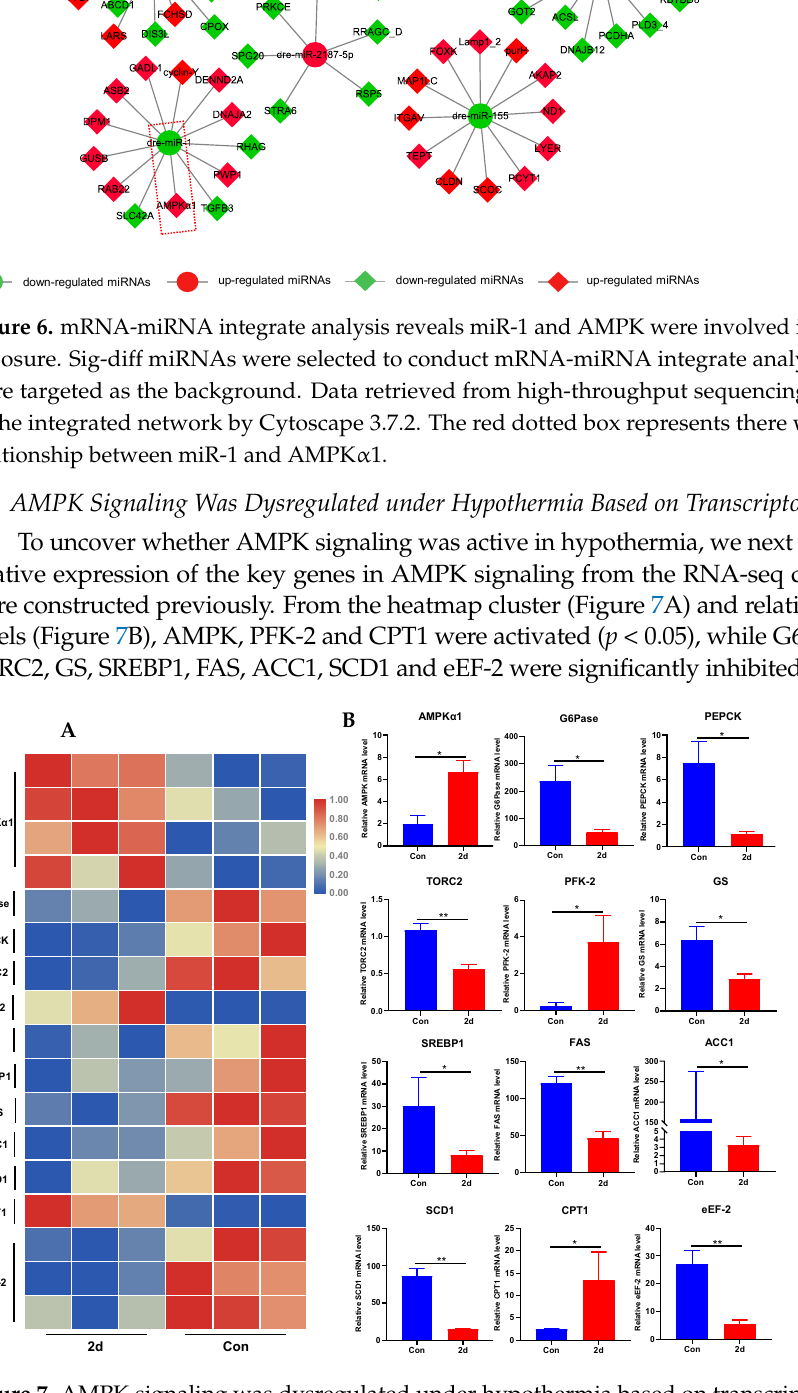
Target predictions indicate that AMPKα1 was the target gene of miR-1 (Figure 8A). To further evaluate whether the AMPK signaling pathway was involved in glucose and lipid metabolism under chronic hypothermia, we investigated the transcriptional expres- sion of key genes. From the results, the regulation between miR-1 and AMPK under chronic hypothermia was confirmed, indicating that the expression of miR-1 was inhib- ited by hypothermia and persisted up to 8 days ( p < 0.05, Figure 8A). Synchronously, the expression of AMPK was also activated at 2 d and 8 d (p < 0.05, Figure 8B). Apart from miR-1 and AMPK, gene expressions of PEPCK, G6Pase, and TORC2 on gluconeogenesis and GS on glycogen synthesis were significantly inhibited at 2 d (Figure 8C–E,G, p < 0.05), while the expression of PFK-2 on glycolysis was activated (Figure 8F, p < 0.05). Importantly, the expression of these genes at 8 d showed no significant changes apart from GS (Figure 8C–G, p > 0.05). Additionally, the mRNA expressions of SREBP1 and ACC1 demonstrated remarkable decreases at 2 d (Figure 8H,K, p < 0.05), while it no- tably increased after hypothermia for 8 days (Figure 8H,K, p < 0.01). Simultaneously, the gene expressions of FAS and SCD1 declined significantly throughout the chronic hypo- thermia (Figure 8I,J, p < 0.05). However, the mRNA expression of CPT1, a crucial gene for fatty acid oxidation, promptly elevated in both groups (Figure 8L, p < 0.05).